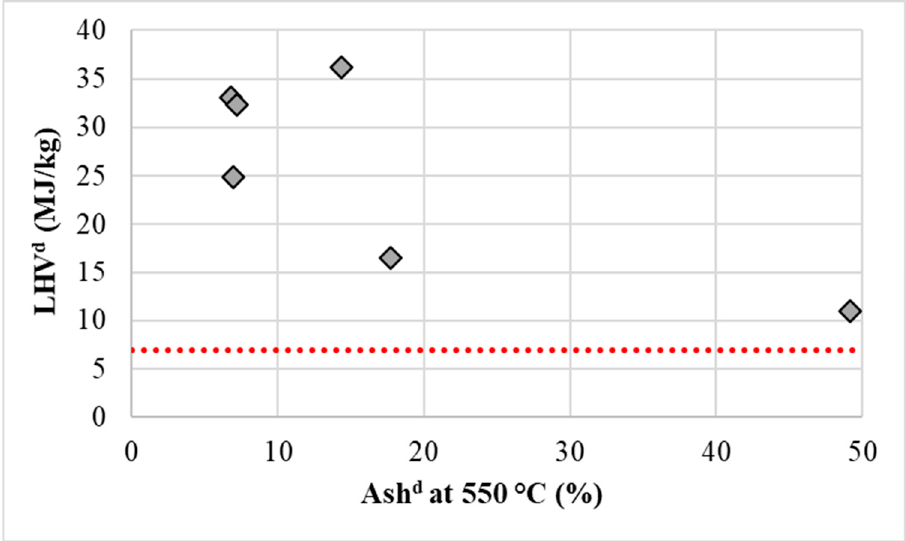
Figure 7. The LHV d (MJ/kg) and ash d at 550 °C (%).